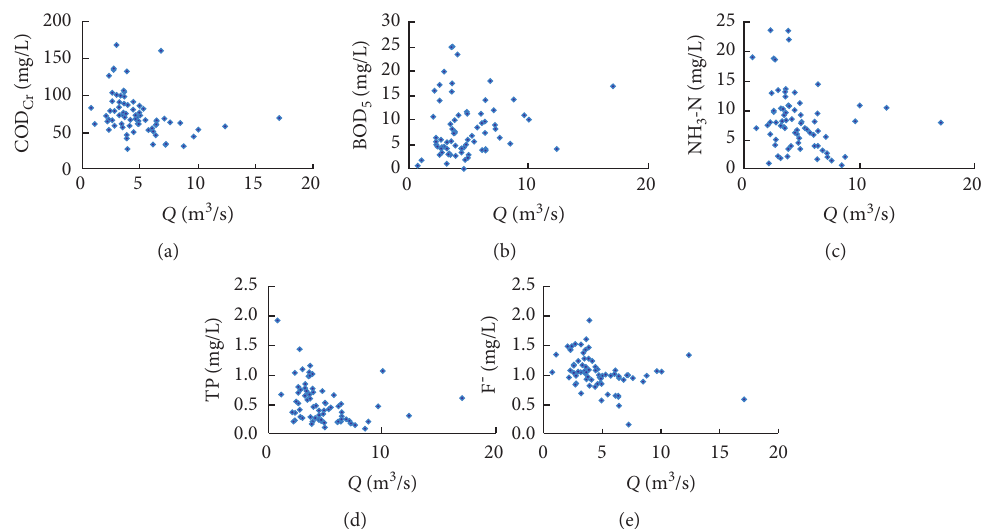
Figure 7: Relationships between the pollutant concentration and discharge at site G5: (a) COD